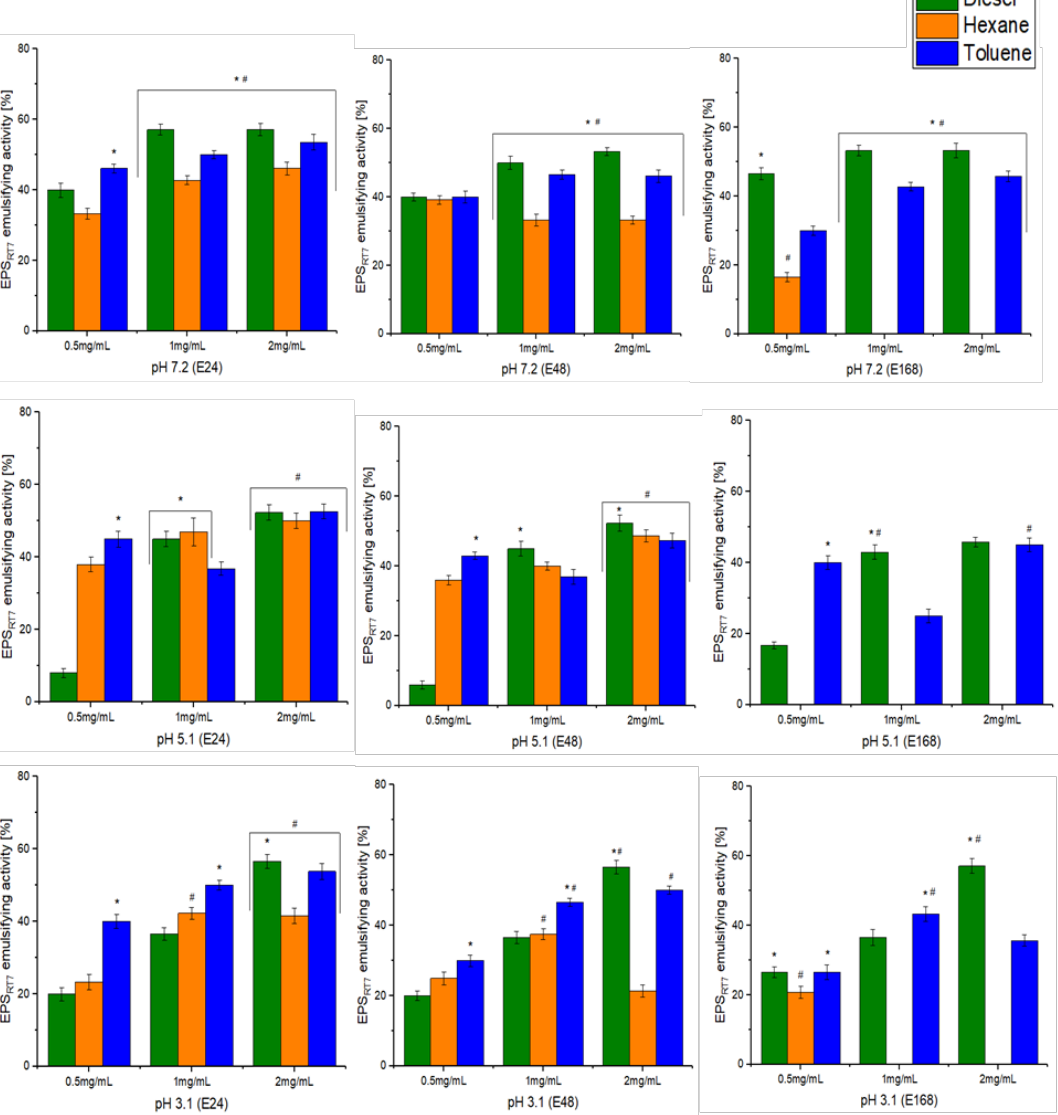
Figure 5. Emulsifying activity for hydrocarbons with different EPS RT7 concentrations (0.5, 1, 2 mg/mL) and pH levels (7.2, 5.1, 3.1), measured at 24, 48, and 168 h of study. *, statistical differences between different hydrocarbons for each concentration ( p < 0.05). #, statistical differences between different concentrations ( p < 0.05).